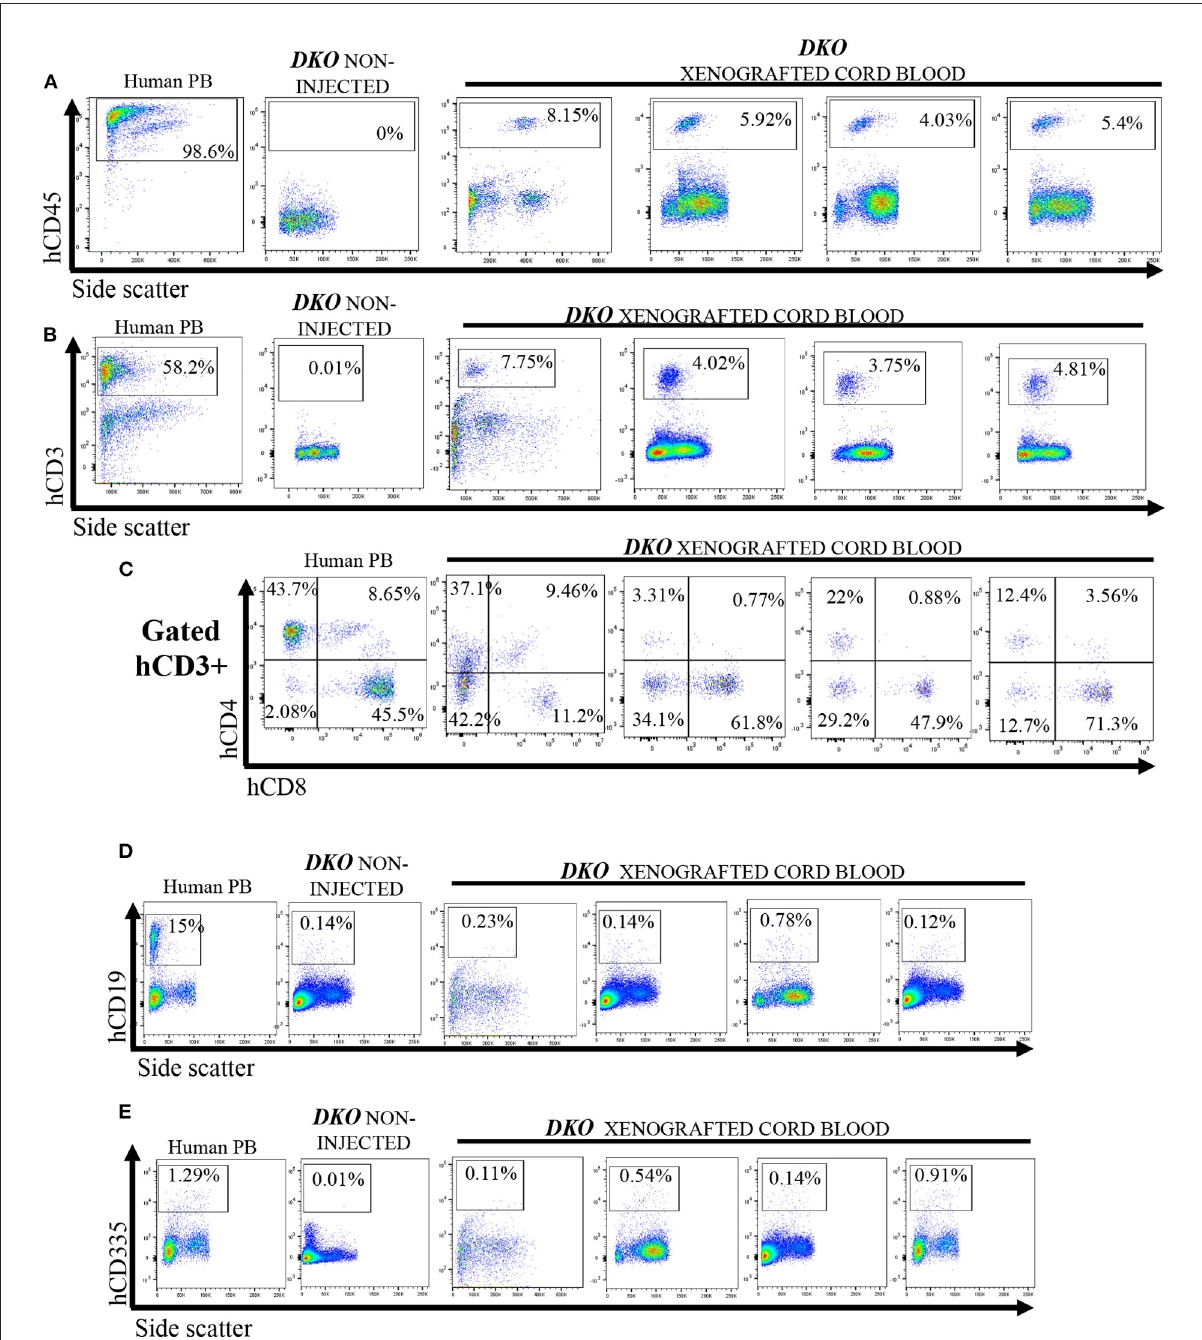
FIGURE5 Cord blood flow cytometry analysis for human T -cells, B cell and NK cells from non-injected and xenografted DKO pigs. Flow cytometry analysis for human lymphoid cells in cord blood from xenografted pigs ( n = 4). Peripheral human blood served as positive controls, while non-injected DKO pigs ( n = 4) served as negative controls. All xenografted pigs ( n = 4) showed; (A) A distinct hCD45 population of circulating mononuclear cells. (B) A hCD3 population of circulating cells with similar percentages as hCD45 cells. (C) Expression of hCD4 and hCD8 among hCD3 + cells, presence of SP hCD4 and SP hCD8, DN and DP. (D) Xenografted DKO pigs showed nearly undetectable levels of hCD19 (B-cells) and a small but significant ( P < 0.05) presence of hCD335 (E) cells when compared to non-injected DKO pigs. Only one representative non-injected animal and human peripheral blood (PB) sample is